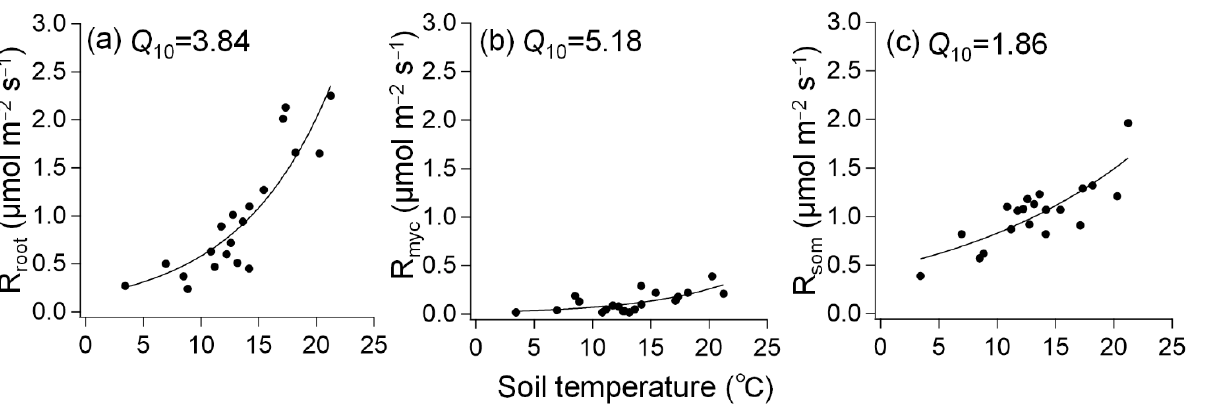
Figure 3. Responses of ( a ) root respiration (R root ), ( b ) mycorrhizal respiration (R myc ), and ( c ) SOM respiration (R som ) to soil temperature in a Larix kaempferi forest. Solid line indicates regression line for all data; p < 0.05. Temperature sensitivity ( Q 10 ) in each soil respiration components are given in this Figure.